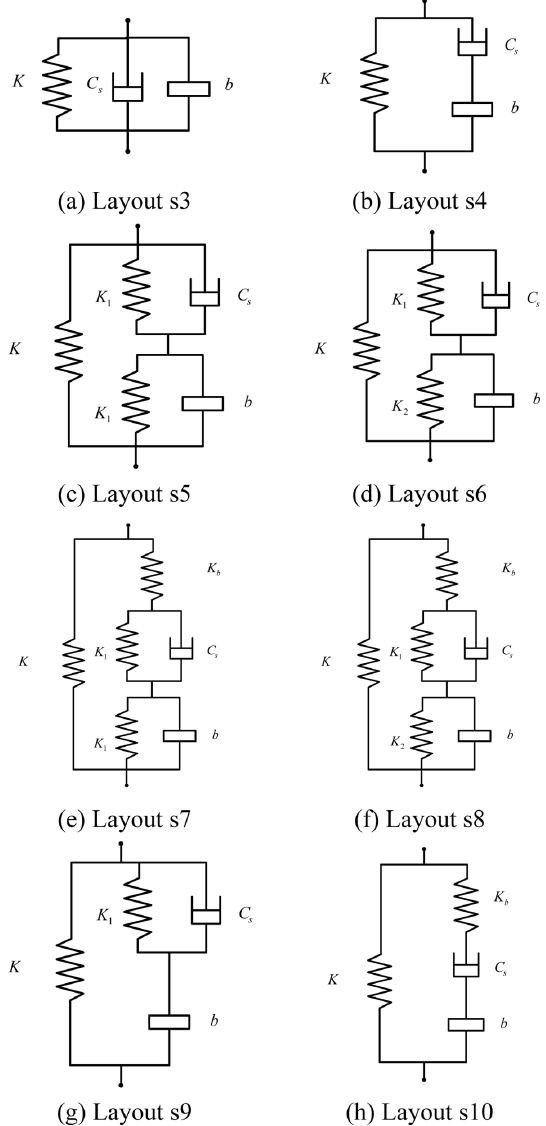
Fig. 3. The eight suspension